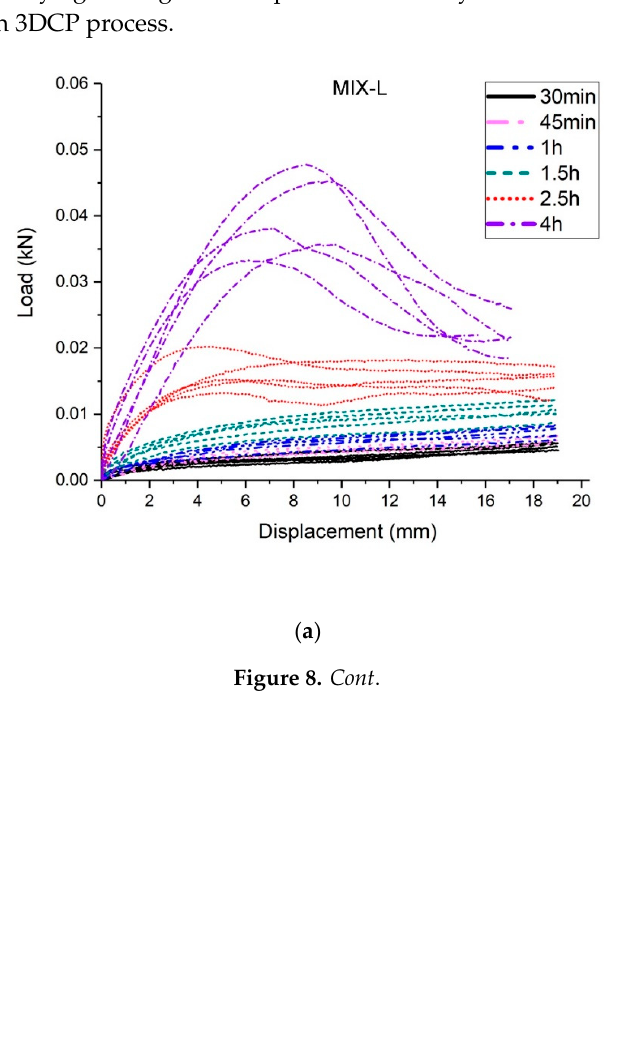
Figure 7. ( a ) Extruded filaments of mixture MIX-L; ( b ) Extruded filaments of mixture MIX-M; ( c ) Extruded filaments of mixture